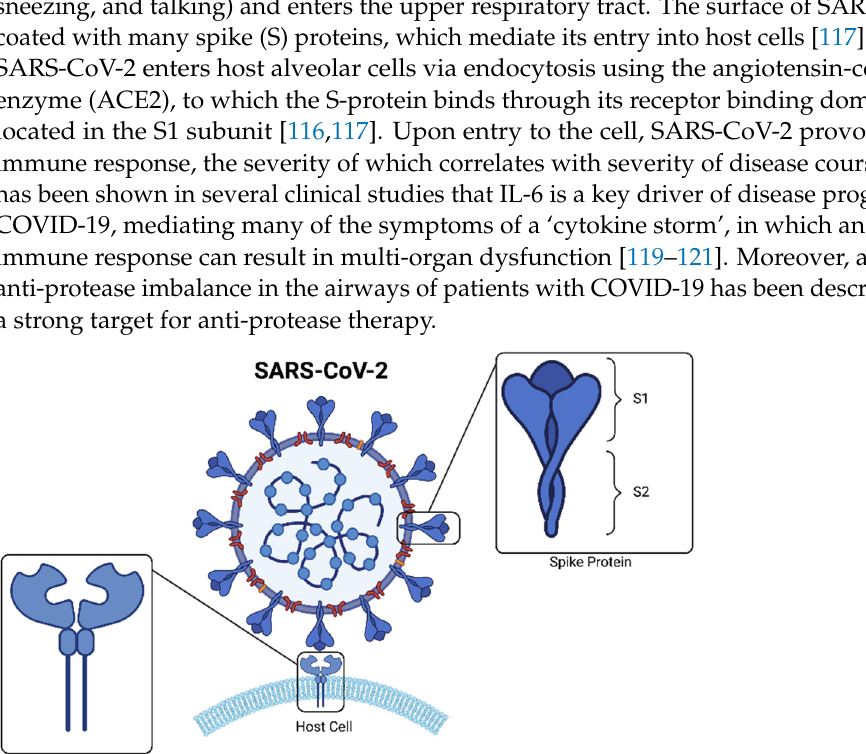
Figure 5. Prophylactic role of heparin in COVID-19 pathophysiology: Binding of low-molecular- weight heparin to the S-protein prevents binding of the S-protein to ACE2 preventing SARS-CoV-2 entry into the host cell and subsequent infection.